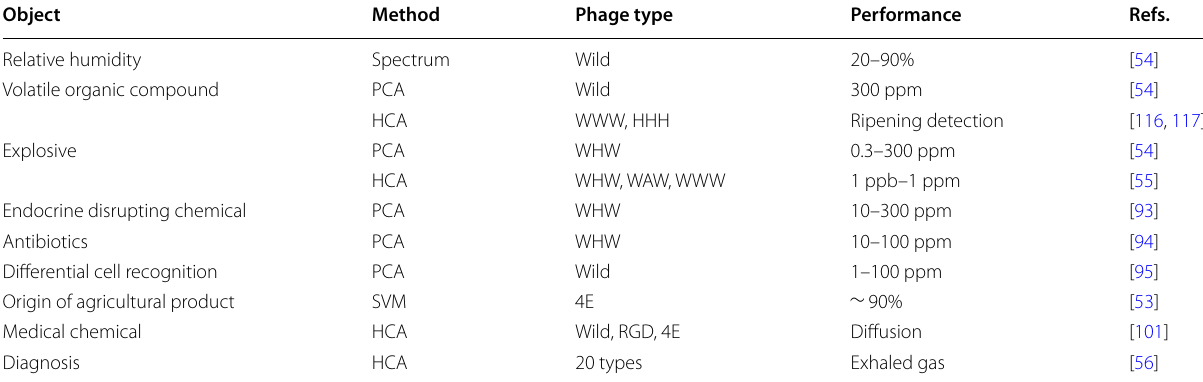
Refer that PCA (Principal component analysis), HCA (Hierarchical cluster analysis), and SVM (Support vector